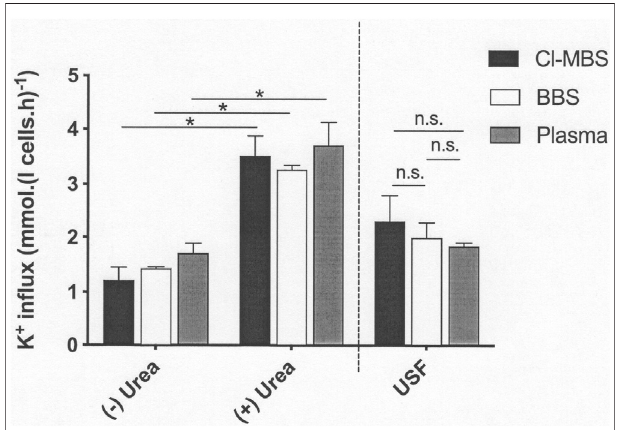
FIGURE 3 | The effect of incubation media on urea-stimulated KCl cotransport activity in LK sheep red cells. Red cells (50% Hct) from LK sheep were equilibrated in Eschweiler tonometers for 15 min at an O 2 tension of 100 mmHg under isotonic conditions (osmolality 290 mOsm.kg − 1 ). ExtracellularpHwaspH7.4,adjustedusingHNO 3 /NaOHinMBS,orwithCO 2 (43 mmHg)inthecaseofBBSandplasma.Redcellaliquotswerethendiluted ten-fold into test tubes pre-equilibrated with the same gas mixtures for measurement of K + in fl ux (extracellular [K + ] of 7.5 mM) over 10 min, in the continuedabsenceofurea(-)orinitspresence(+)at750 mM.Allin fl uxeswere carried out in the presence of ouabain (100 µM) and bumetanide (10 µM) to inhibit K + in fl ux through the Na + /K + pump and NKCC, respectively. The urea- sensitiveK + fl ux(USF)representsthechangesof fl uxinducedbythepresence of high urea concentrations (750 mM) compared with that measured in its absence. Histograms represent means ± S.E.M., n = 4. p p ≤ 0.05; n.s. indicates “ not signi fi cant ”